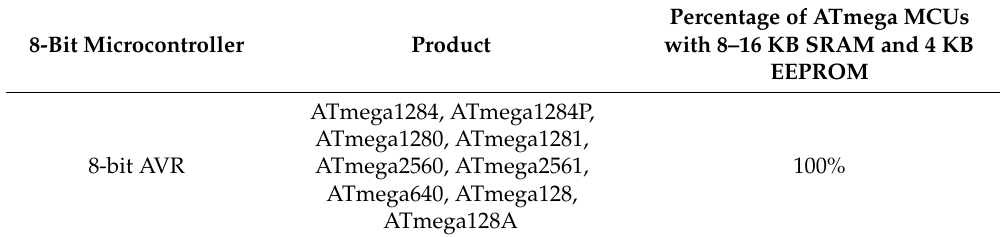
Table 3. 8-bit AVR products whose SRAM size is 8–16 KB.